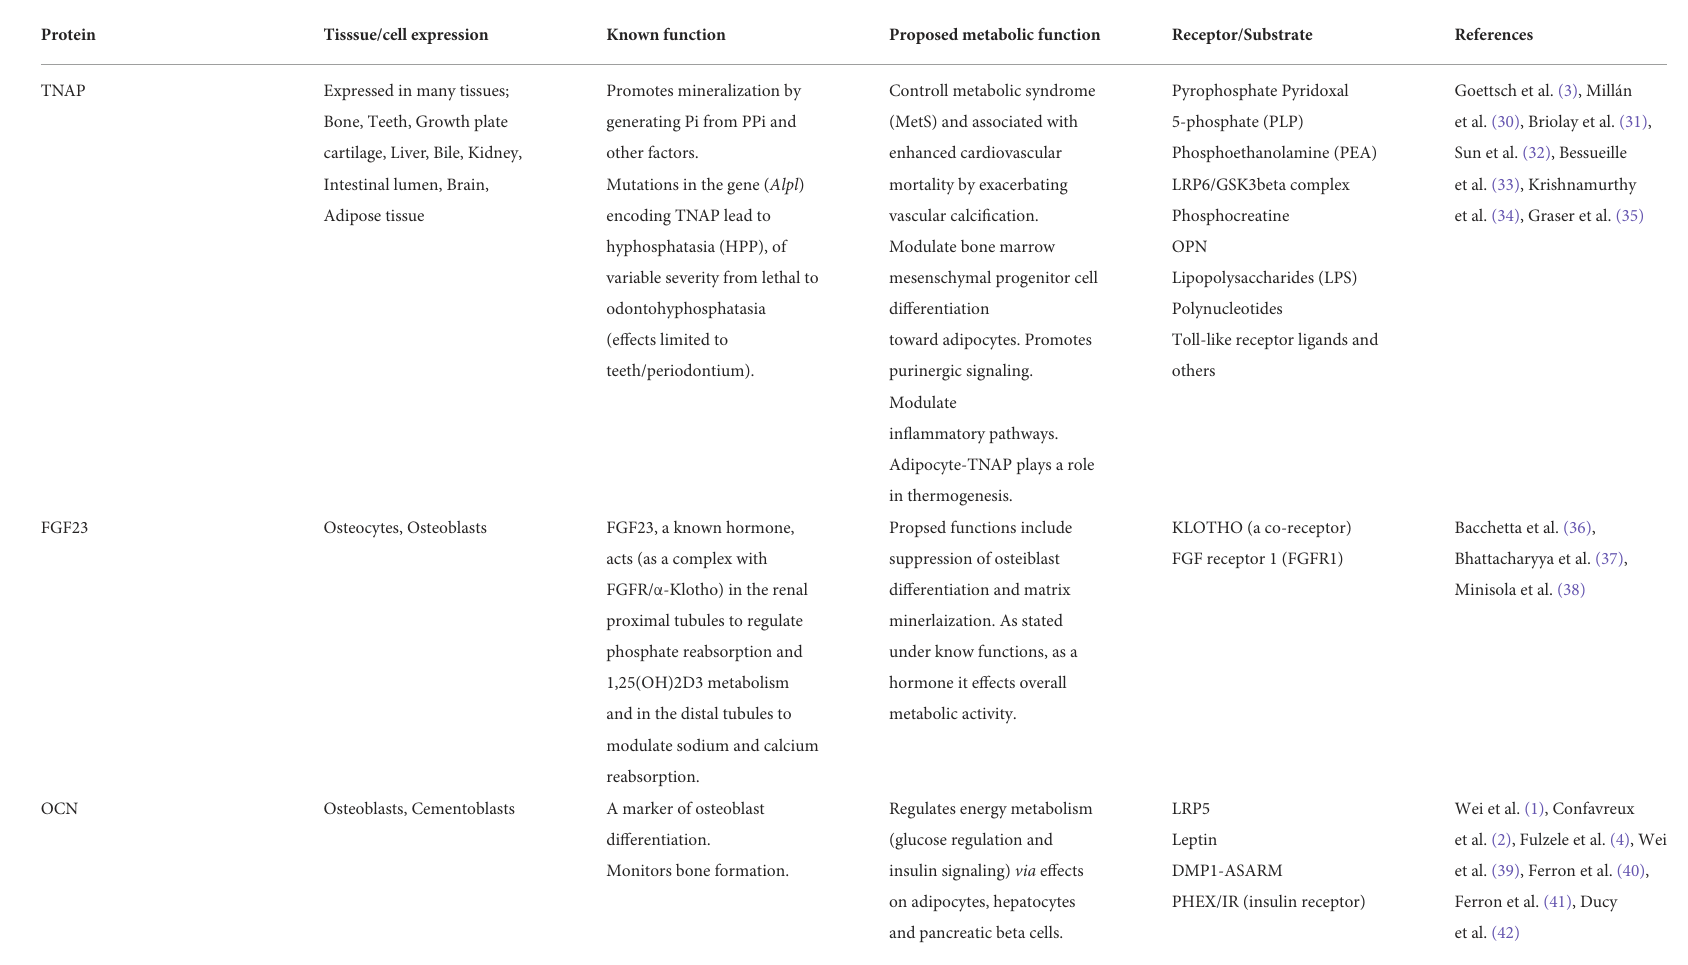
TABLE 2 Non-RGD proteins and metabolic